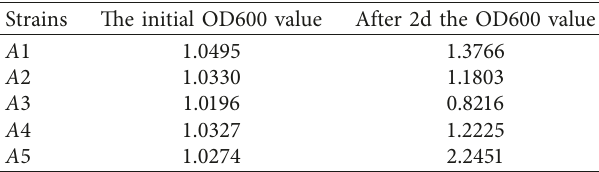
Table 1: Summary table of OD600 value change. Strains The initial OD600 value After 2d the OD600